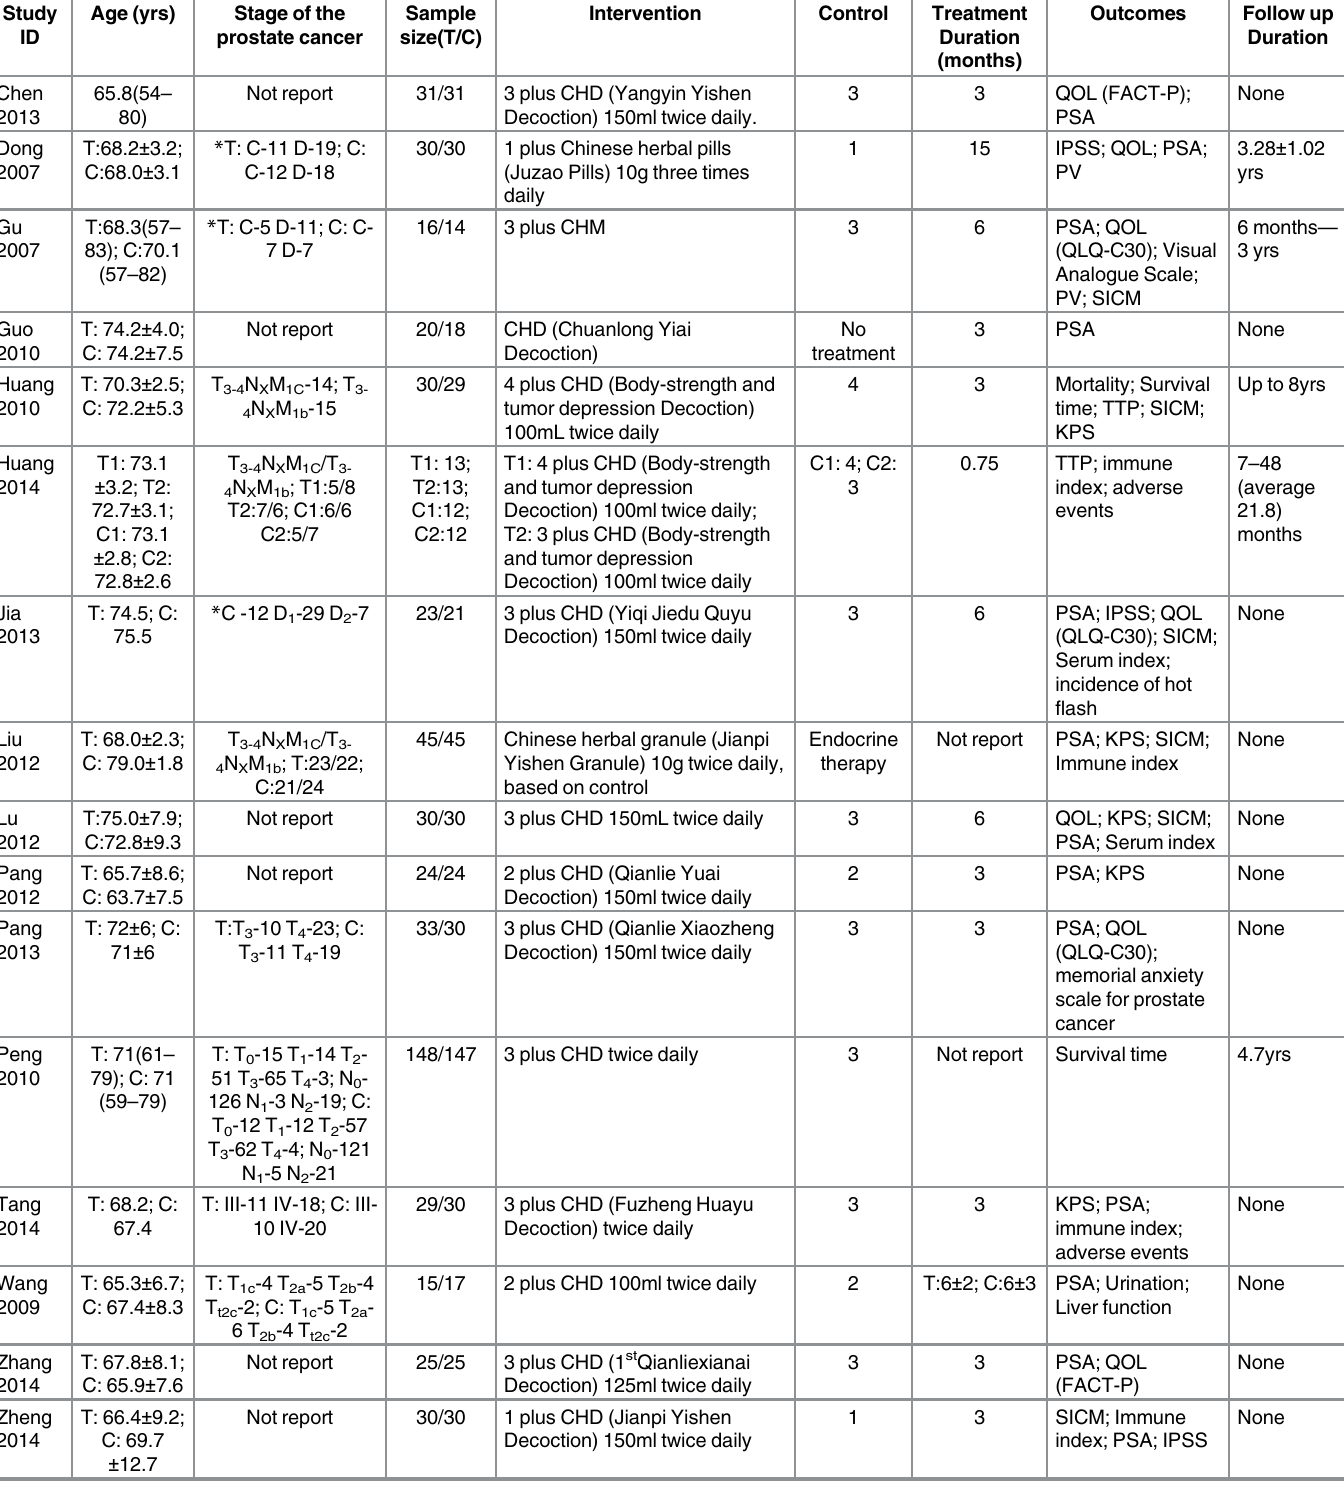
Table 1. Characteristics of 17 included